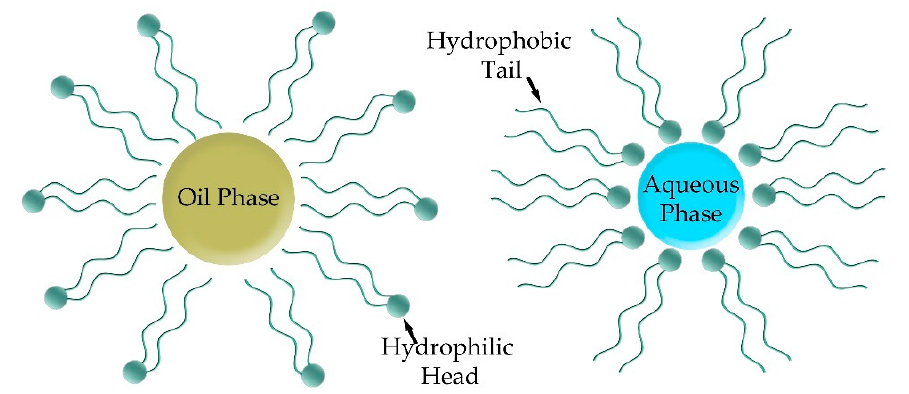
Figure 5. Micelle ( left ) and reverse micelle ( right ).